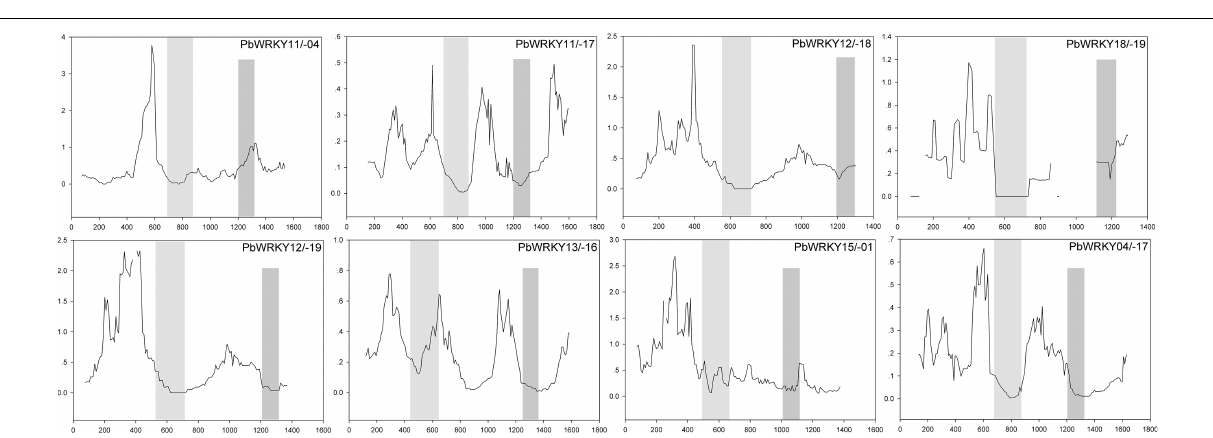
FIGURE 6 | Sliding window analysis of duplicated WRKY I genes in P. bretschneideri . As shown in the key, the gray blocks, from light to dark, represent the positions of the first WRKY domain, and the second WRKY domain, respectively. The step size is 9 bp, and the window size is 150